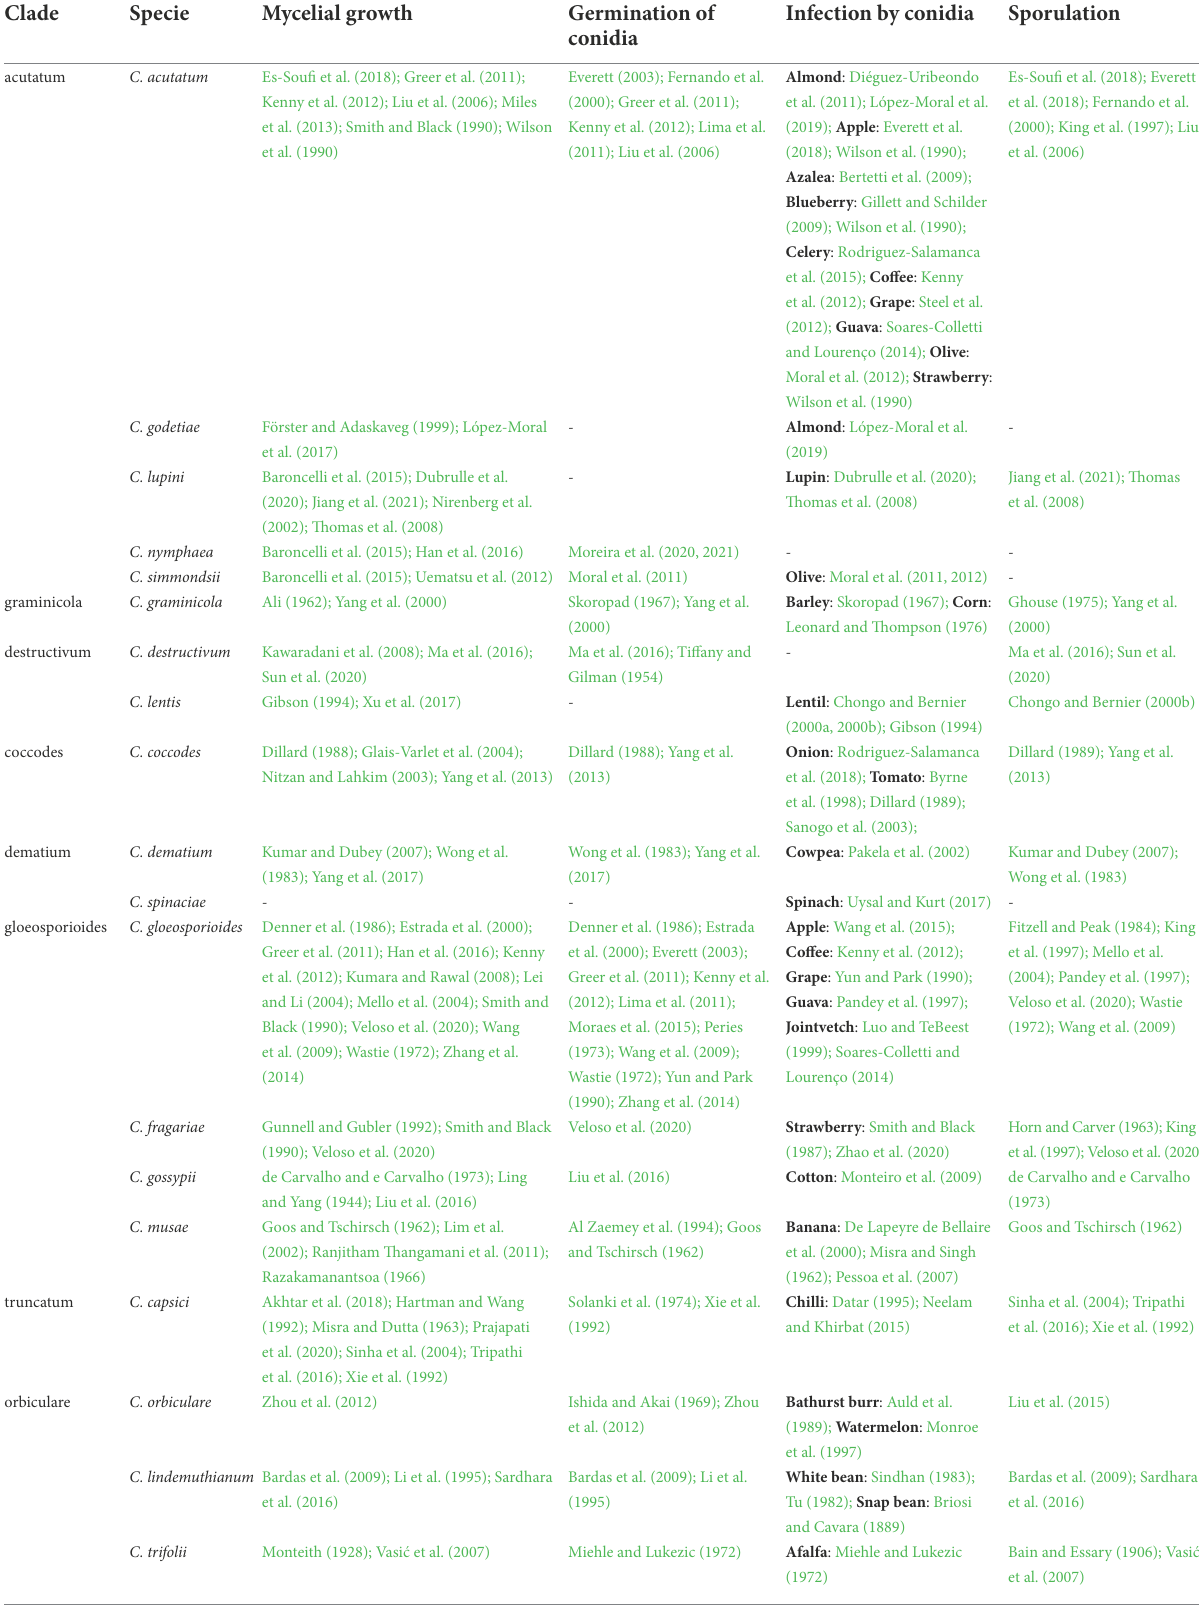
TABLE 3 Species of Colletotrichum grouped by clade (Cannon et al., 2012) included in this work, and publications reporting specific experiments concerning the effect of temperature on four biological